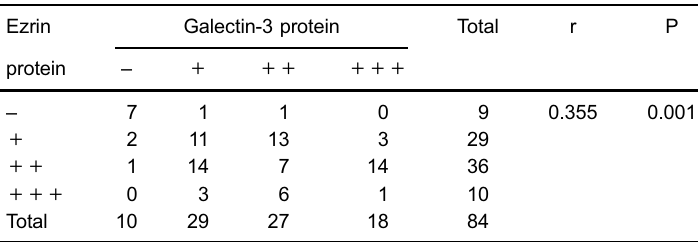
FIGO: International Federation of Gynecology and Obstetrics; ( – ): negative; ( + , ++ , +++ ): positive. *P o 0.05 compared with well- differentiated patients. Table 4. Correlations between ezrin and galectin-3 protein expression in cervical